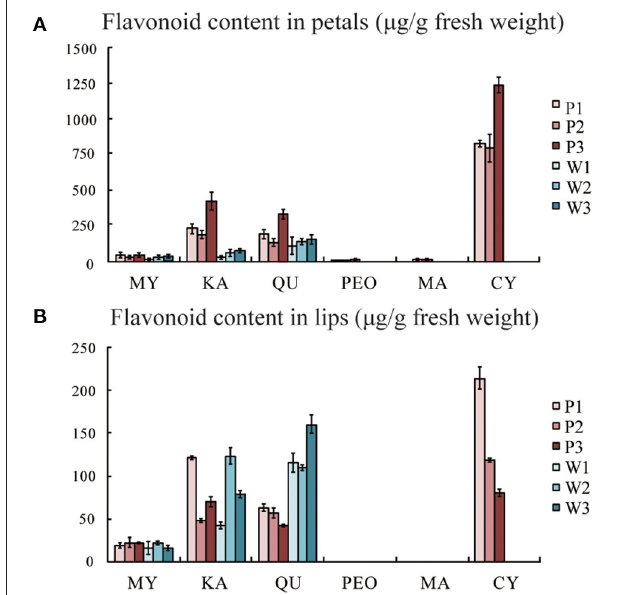
FIGURE 3 | Flavonoid composition analysis by HPLC from flowers of purple-red and white C. kanran . (A) Flavonoid content in petals. (B) Flavonoid content in lips. MY, myricetin; KA, kaempferol; QU, quercetin; PEO, peonidin; MA, malvidin; CY, cyanidin; P1, purple-red C. kanran 1; W1, white C. kanran